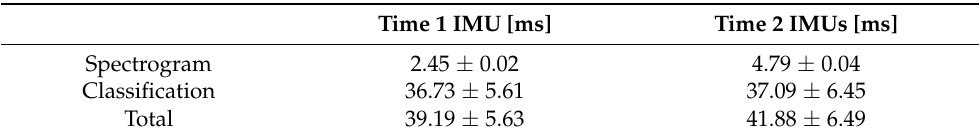
Table 8. Running time for the classification of one sequence (averaged over 1000 data) when using one and two